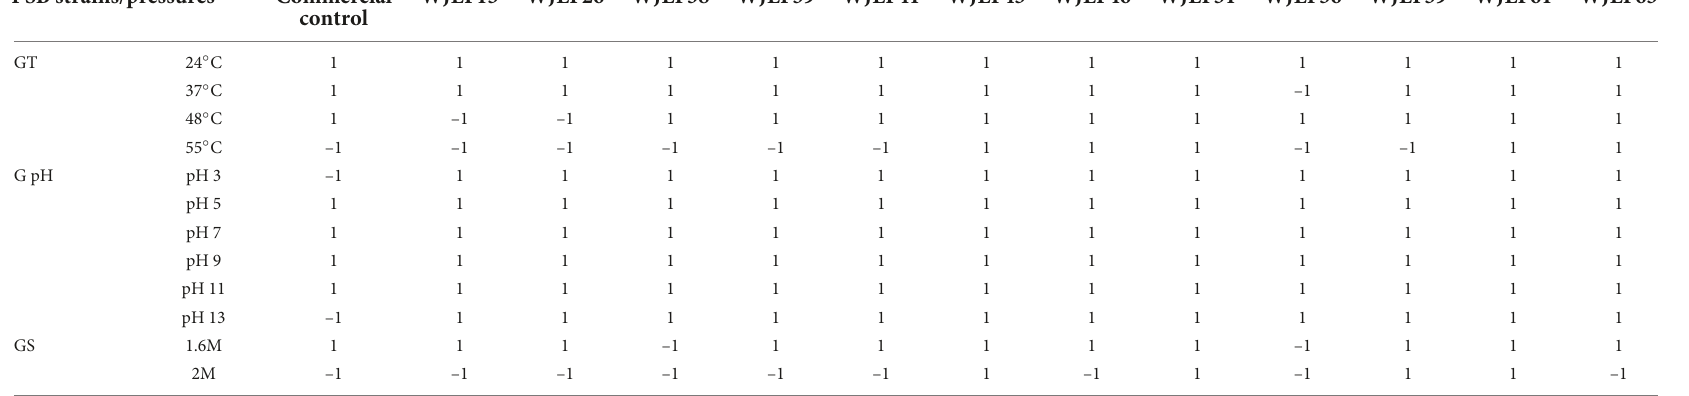
TABLE 9 Physiological characteristics of selected isolates under temperature, pH, and salinity pressure. PSB